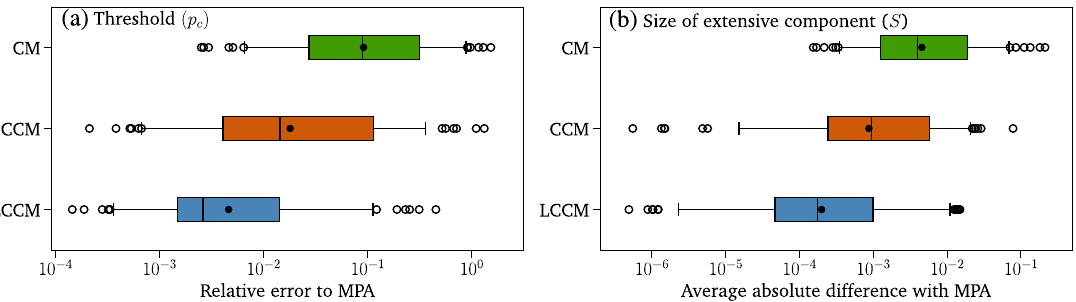
FIG. 3. Predictions of the intensive models (CM, CCM, and LCCM) compared to the predictions of the extensive MPA for a collection of 111 real network datasets from different scientific domains, including, but not limited to, social networks (where nodes are often people and links are interactions), biological networks (e.g., protein-protein interaction networks), connectomes (e.g., axonal connections between brain regions), food webs, infrastructure networks (e.g., power grids), and transportation networks (e.g., flights between airports). Further details are provided in Appendix F. The whiskers cover the range between the fifth and the 95th percentiles, the black dots indicate the mean, and the outliers ’ data points are shown with a circle. Each box indicates the first, second, and third quartiles, as usual. (a) Relative error of the percolation threshold defined as j p model in Appendix D. (b) Area of the region bounded by the curves S model and S MPA computed as